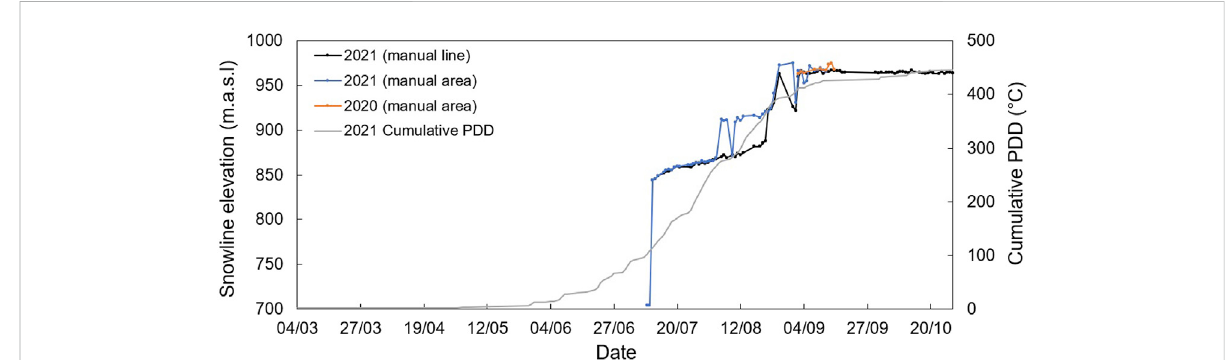
FIGURE 4 Maximum snowline elevation on QAS during the 2020 and 2021 summer melt seasons, derived from manual classi fi cation in PyTrx. Snowline positions delineated as lines are shown in black. Snowline positions (i.e. bare ice areas) delineated as polygons are shown in blue and orange. Each individual dot represent the maximum elevation of a snowline position classi fi ed from a single time-lapse camera image on one date in the melt season. The drop in maximum snowline elevation on the 9th August 2021 is due to light snowfall covering the bare ice patches on the upper portion of QAS, which subsequently melted the following day.